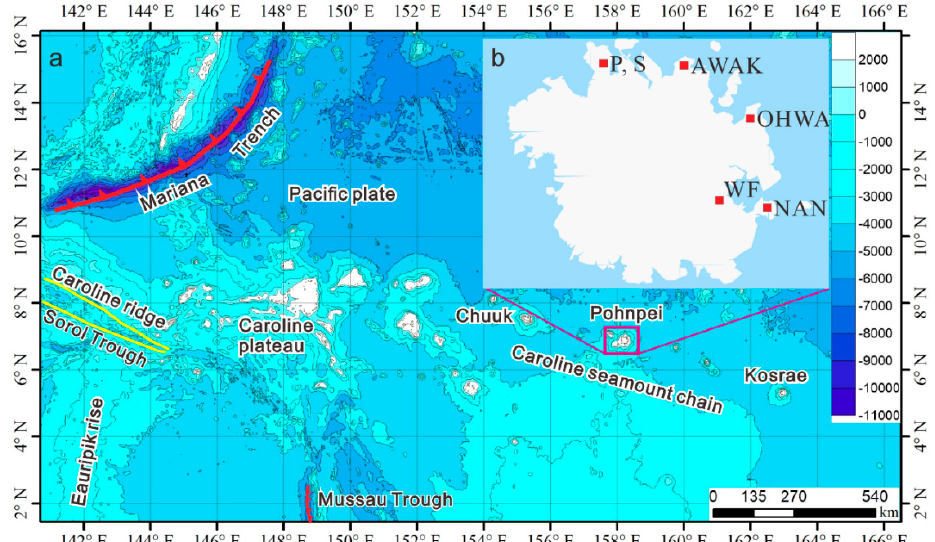
Figure 1. ( a ) Bathymetric map of the Caroline Seamount Chain showing the major tectonic features of the seamount chain, Caroline Plateau, and adjacent areas. ( b ) The sampling locations on the Pohnpei Island. The abbreviations P, S, AWAK, OHWA, WF, and NAN represent sampling stations, as described in Table 1.